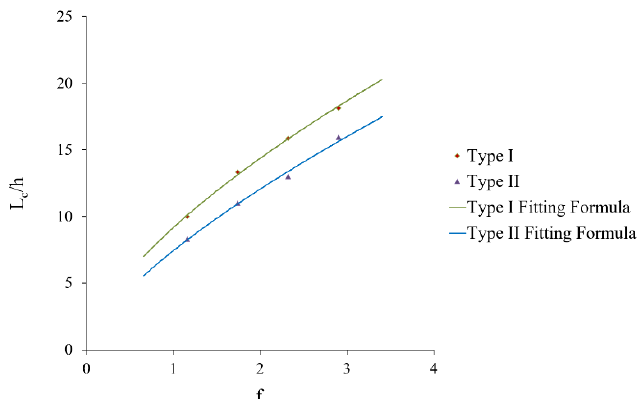
Figure 7. Step air entrainment concentration: ( a ) Type I, ζ = 0.714; ( b ) Type II, ζ = 0.714; ( c ) Type I, ζ = 0.936; ( d ) Type II, ζ = 0.936; ( e ) Type I, ζ = 1.134; ( f ) Type II, ζ = 1.134; ( g ) Type I, ζ = 1.316; ( h ) Type II, ζ = 1.316.